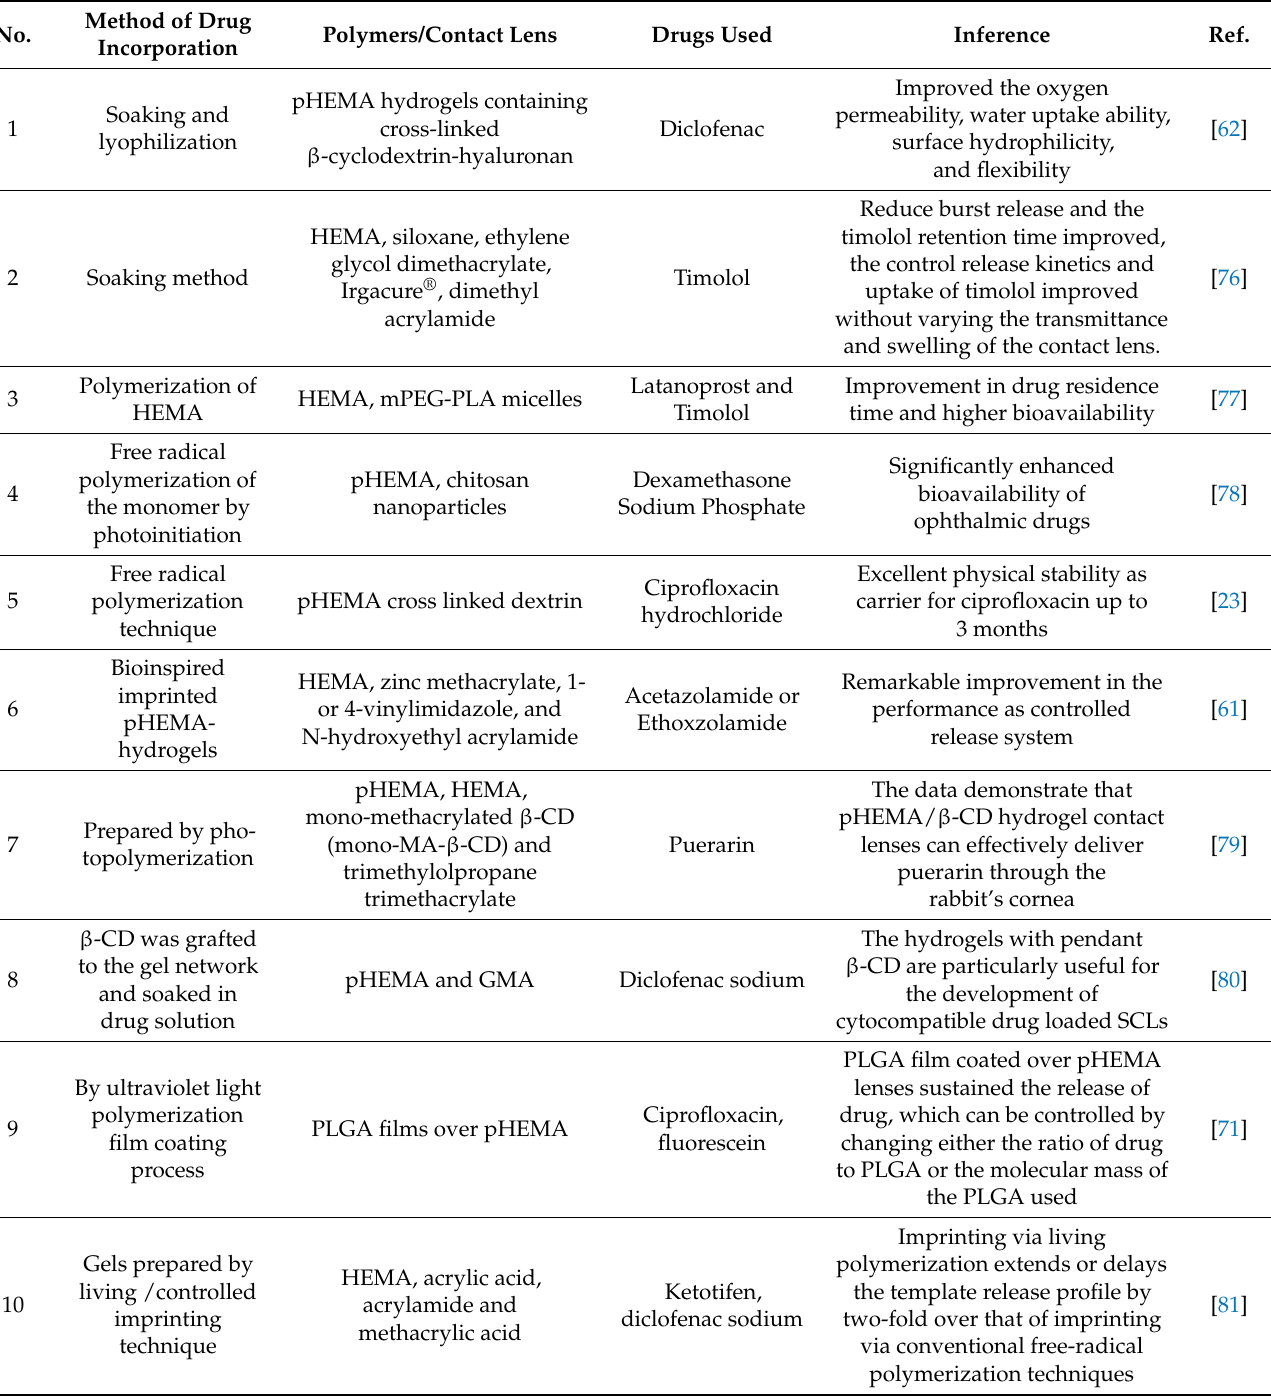
Table 2. Various approaches and drugs used for contact lens drug